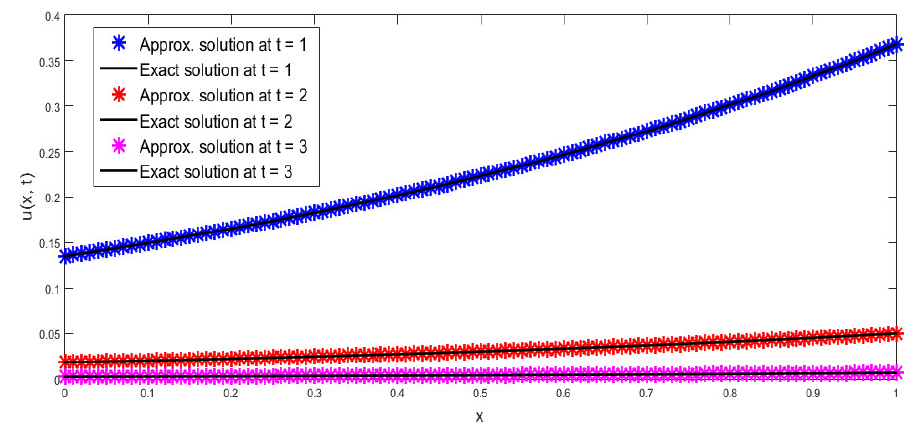
Figure 1. Comparison of approx. and exact profiles at t = 1, 2, 3 regarding Example 1.